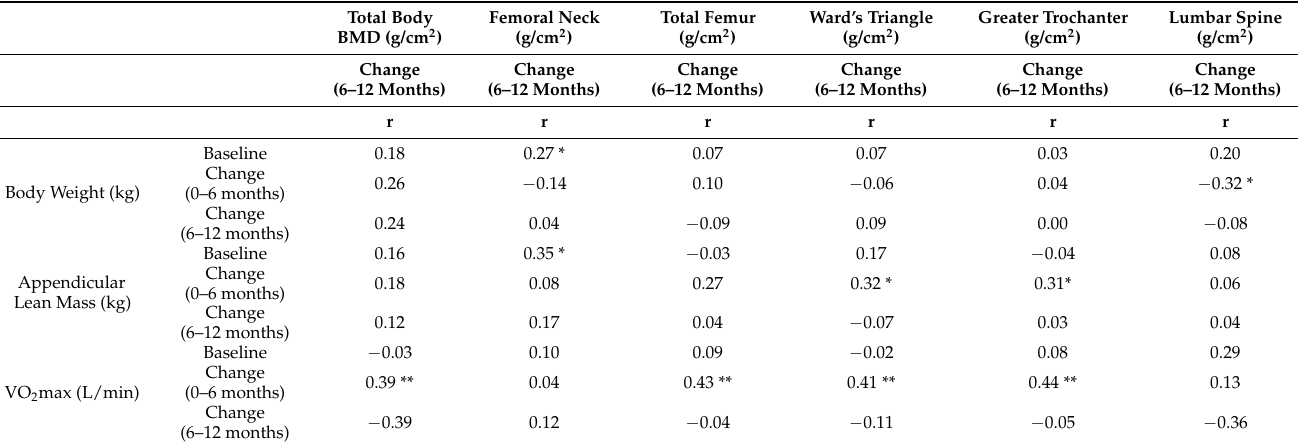
Table 2. Predictors of BMD changes during weight regain ( N =